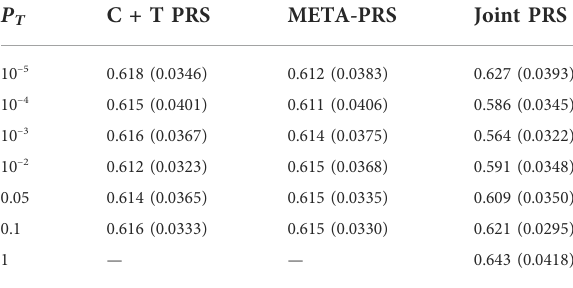
TABLE 3 Median and interquartile range for AUC of different PRS models as a function of p -value threshold P T . For each model and value of P T , estimates are obtained by averaging results across ten repeated instances of 5-fold cross-validation.